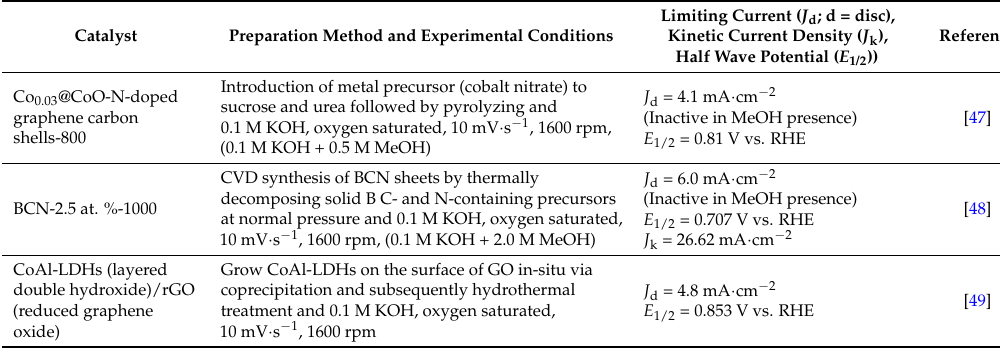
Table 2. Non ‐ precious hybrid ORR electrocatalysts. Table 2. Non-precious hybrid ORR